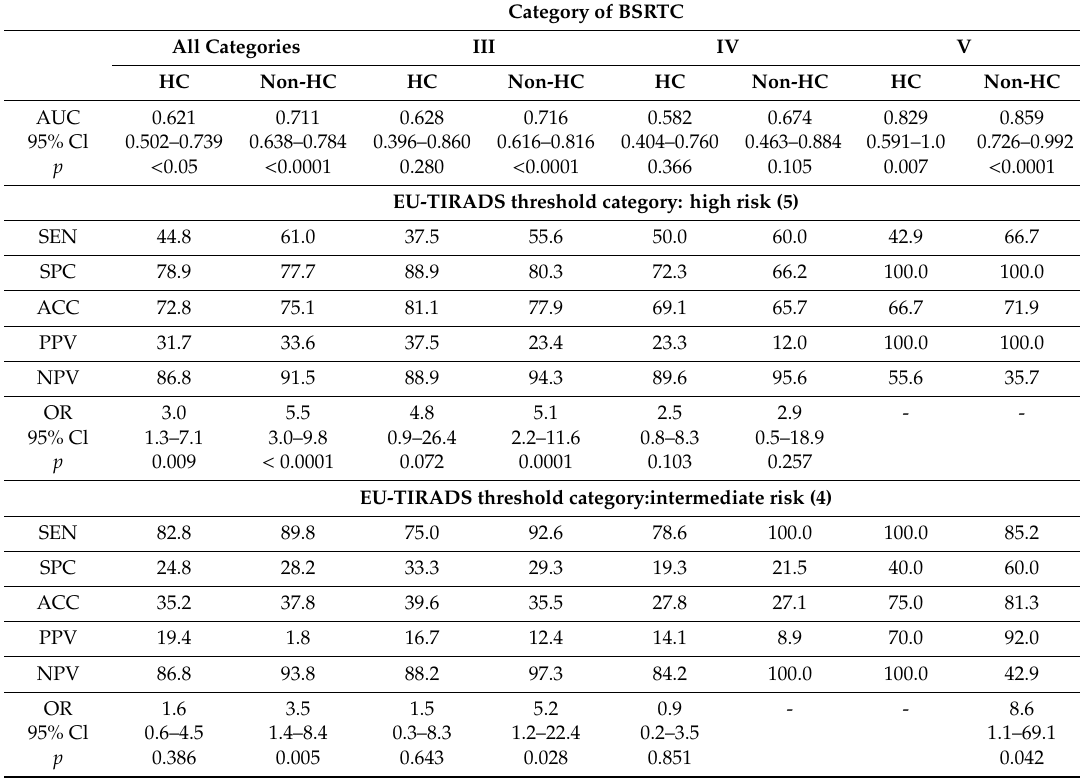
Table 4. Data on the diagnostic e ffi cacy of EU-TIRADS in relation to the category of Bethesda System for Reporting Thyroid Cytopathology (BSRTC) in examined groups of